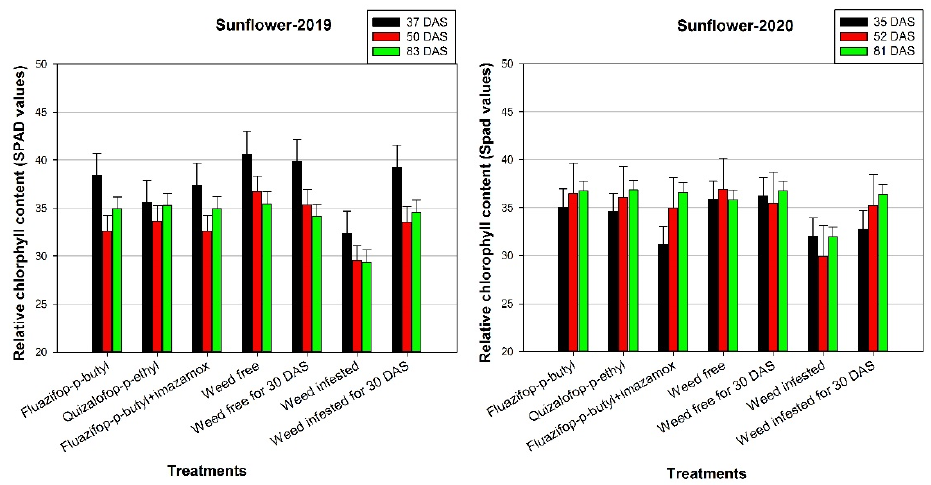
Figure 5. Effects of various control treatments of Johnsongrass on relative chlorophyll content (SPAD values) of sunflower at different days after sowing (DAS), in 2019 and 2020. For each sampling date, error bars indicate the LSD 5%